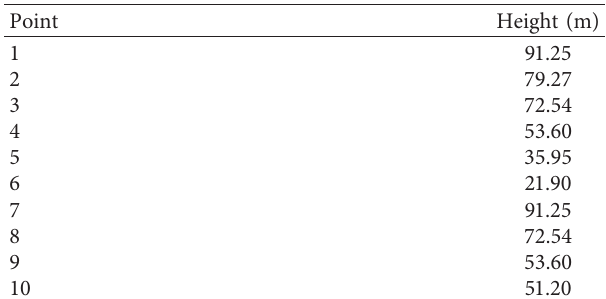
Table 4: The heights of reference